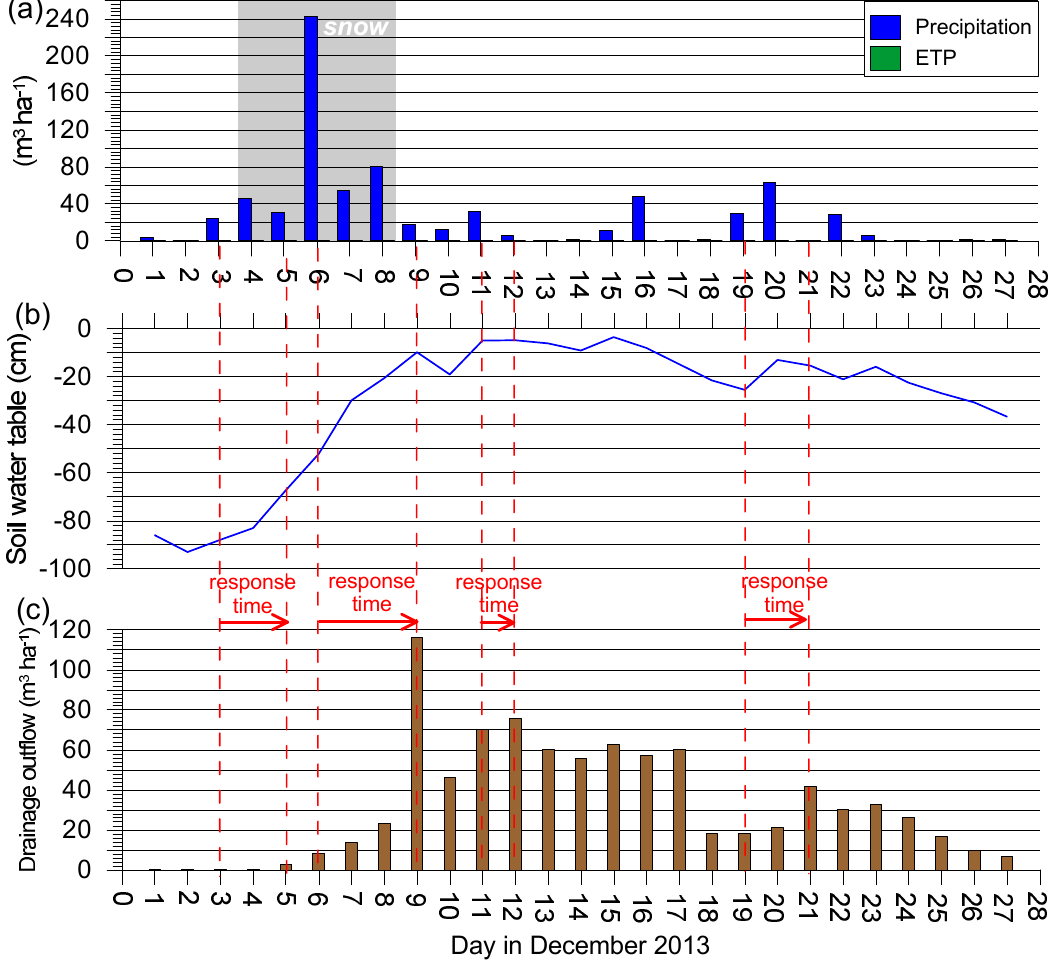
Figure 7. Daily values of precipitation and potential evapotranspiration ( a ), groundwater table ( b ), and drainage outflow ( c ) during the December 2013 observation period.